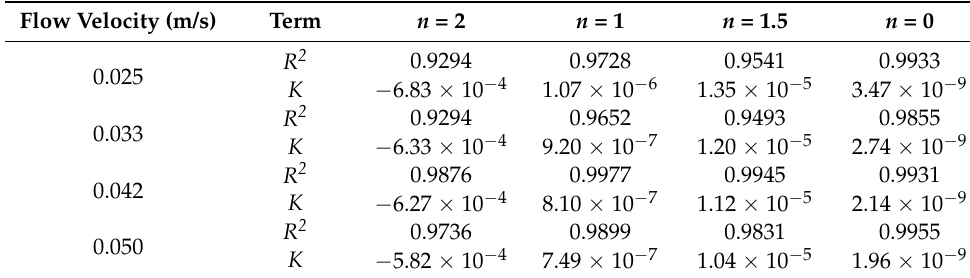
Table 6. R 2 values and K constants in the Hermia model at different cross-flow velocities.